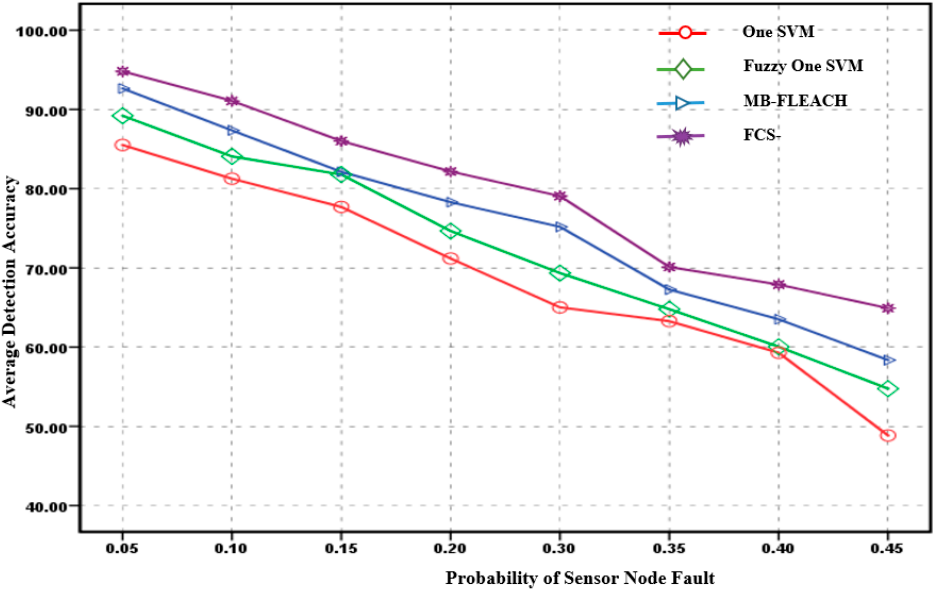
Figure 8. Average detection accuracy of sensor node faults with a density equal to 10 for the first scenario.